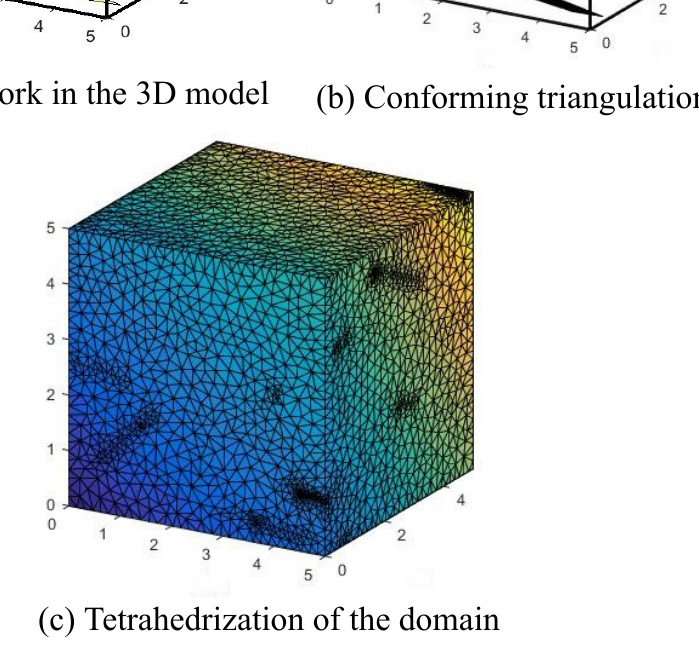
Figure 13. Distribution of fractures in the porous, fractured rock